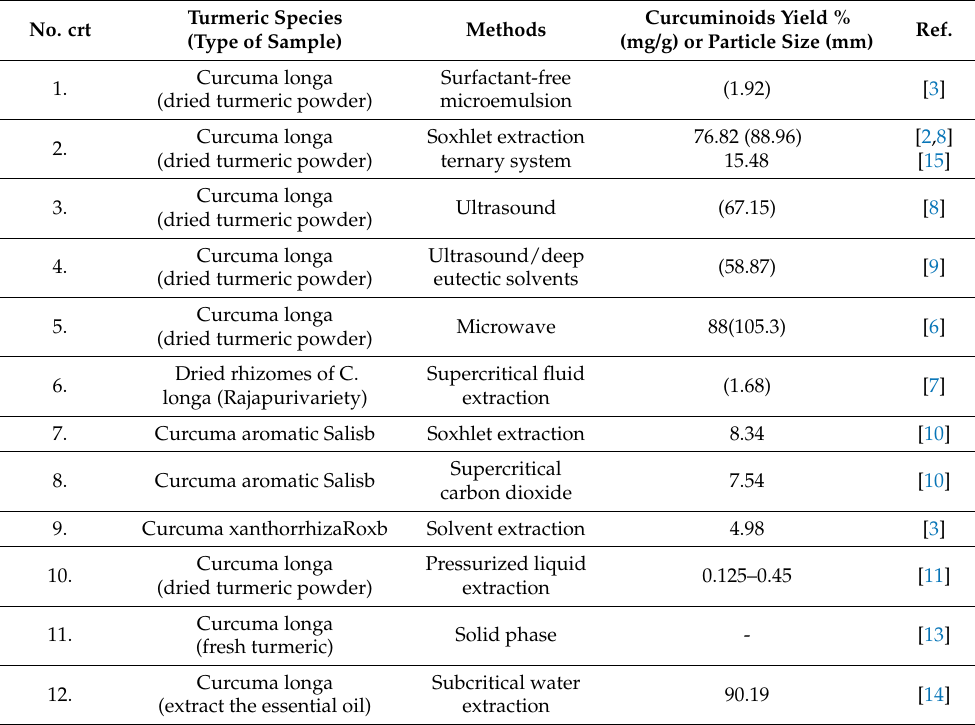
Table 1. Methods for obtaining curcumin